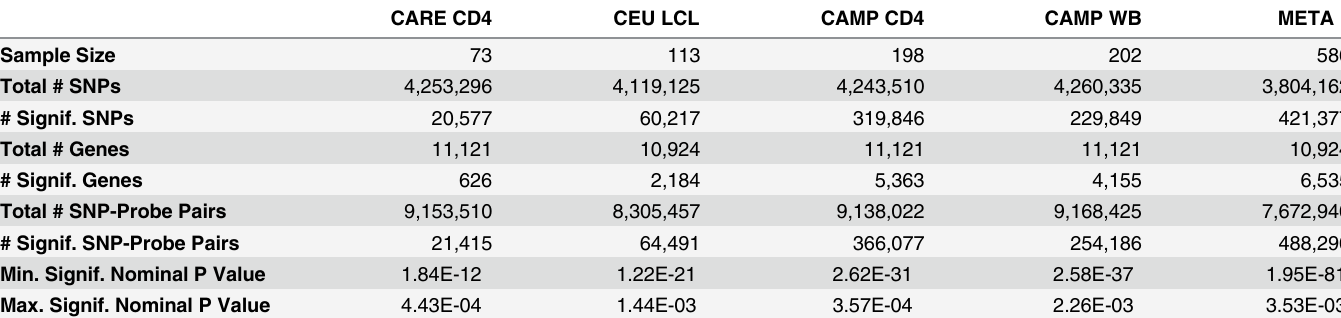
Table 1. Summary characteristics of cohort-specific and meta-analysis eQTL results.